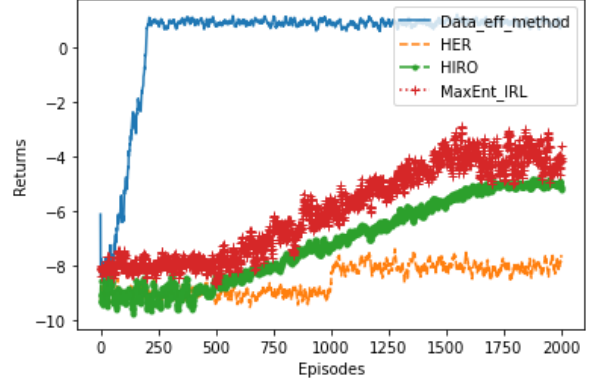
Figure 5. Training curves of the four methods.